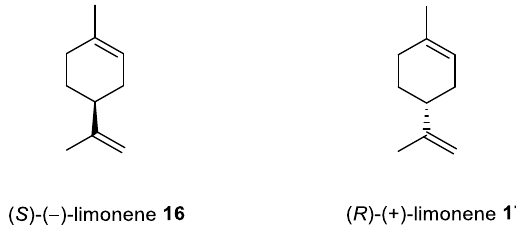
Figure 7. Stereoisomers of